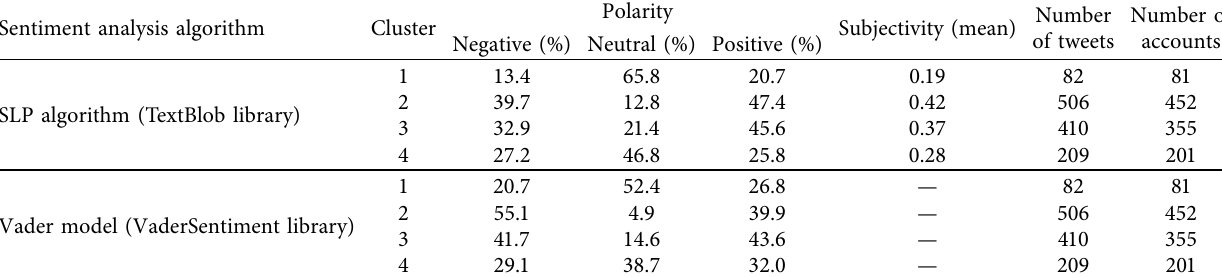
Table 7: Sentiment analysis results for Scenario 2 using SLP Algorithm versus Vader model.